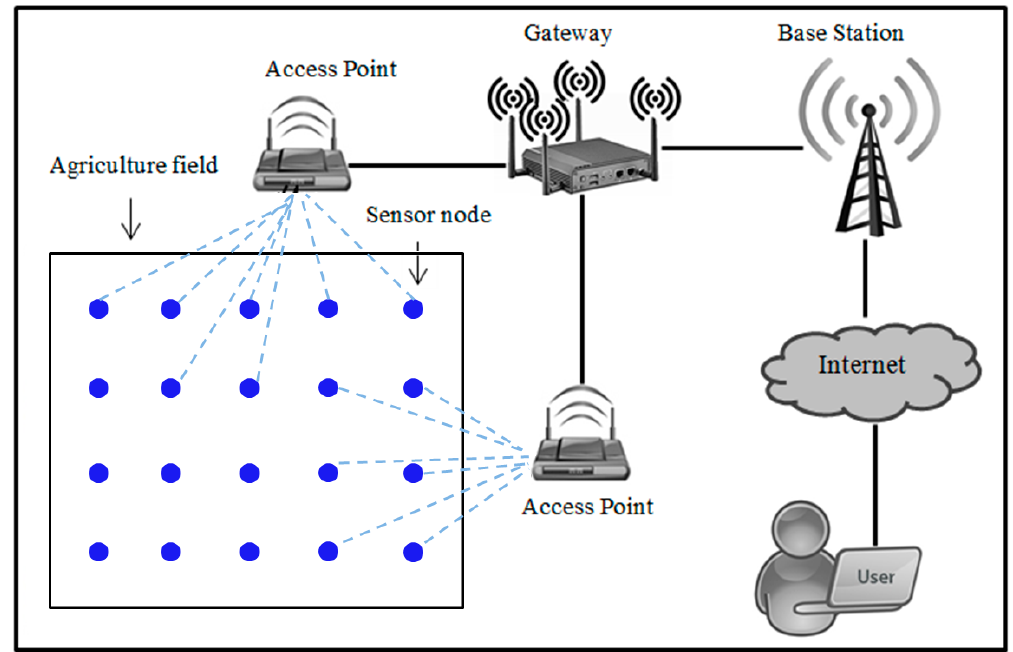
Figure 1. Agriculture monitoring system model of the proposed scheme.